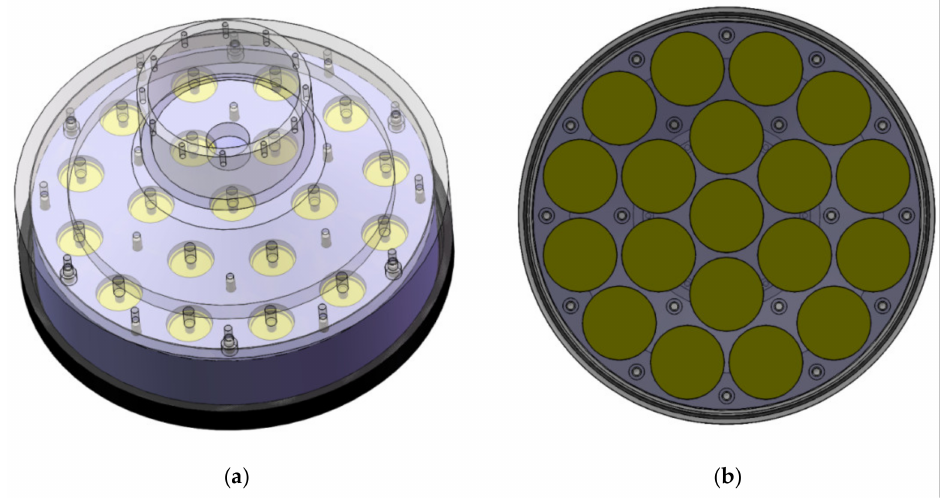
Figure 6. The shipborne transducer array of the Fendouzhe HOV. ( a ) perspective view, ( b ) schematic diagram of array element